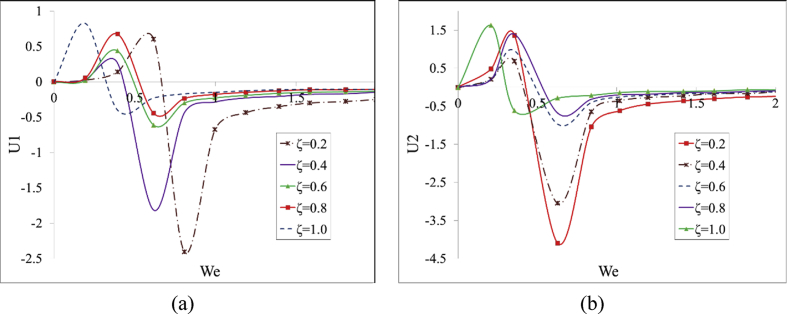
The variations of a) U1, and b) U2 as a function of We for ε=0.04, ​Re=0.2 ​ and Δp=−1.